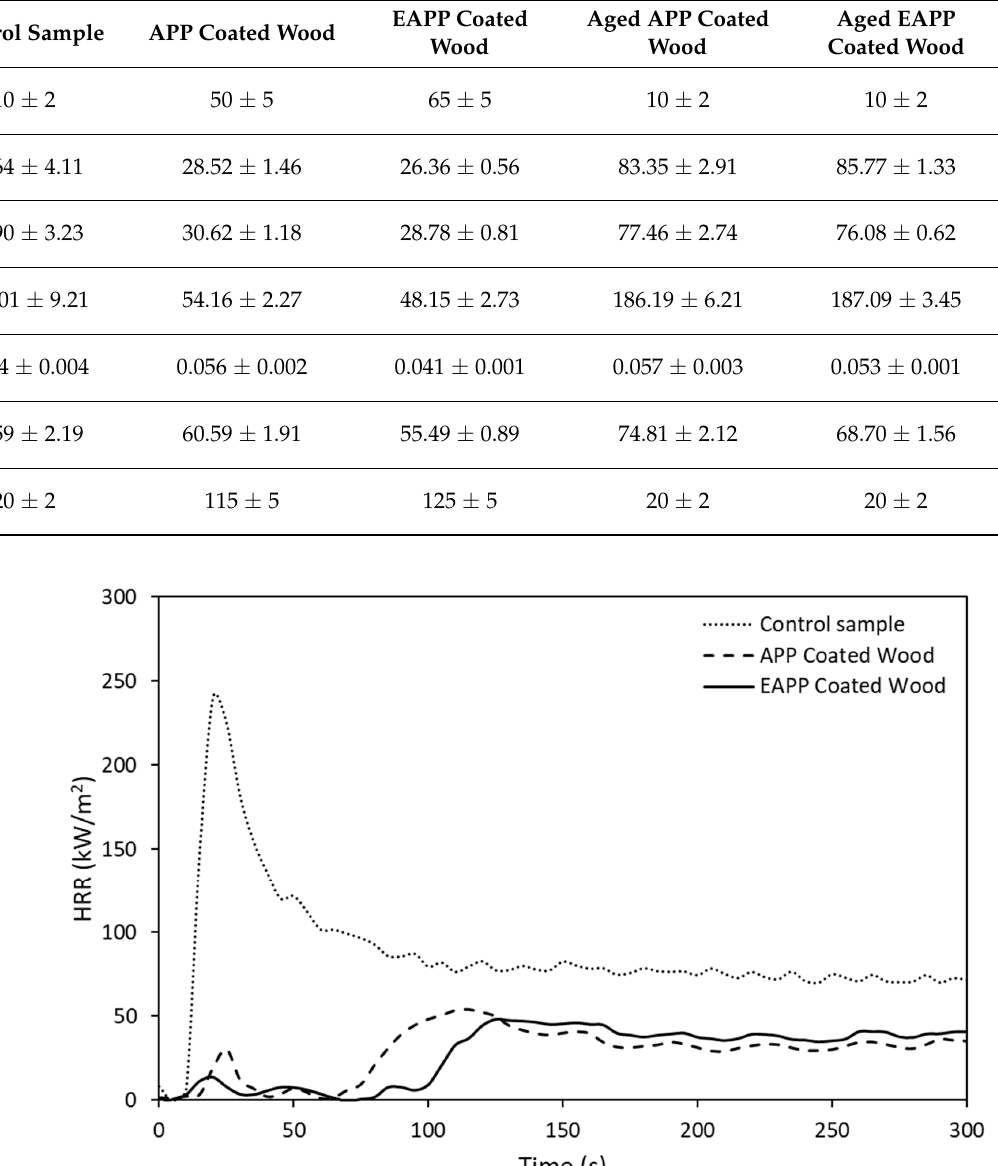
Table 5. Fire properties of the samples from the cone calorimeter test.